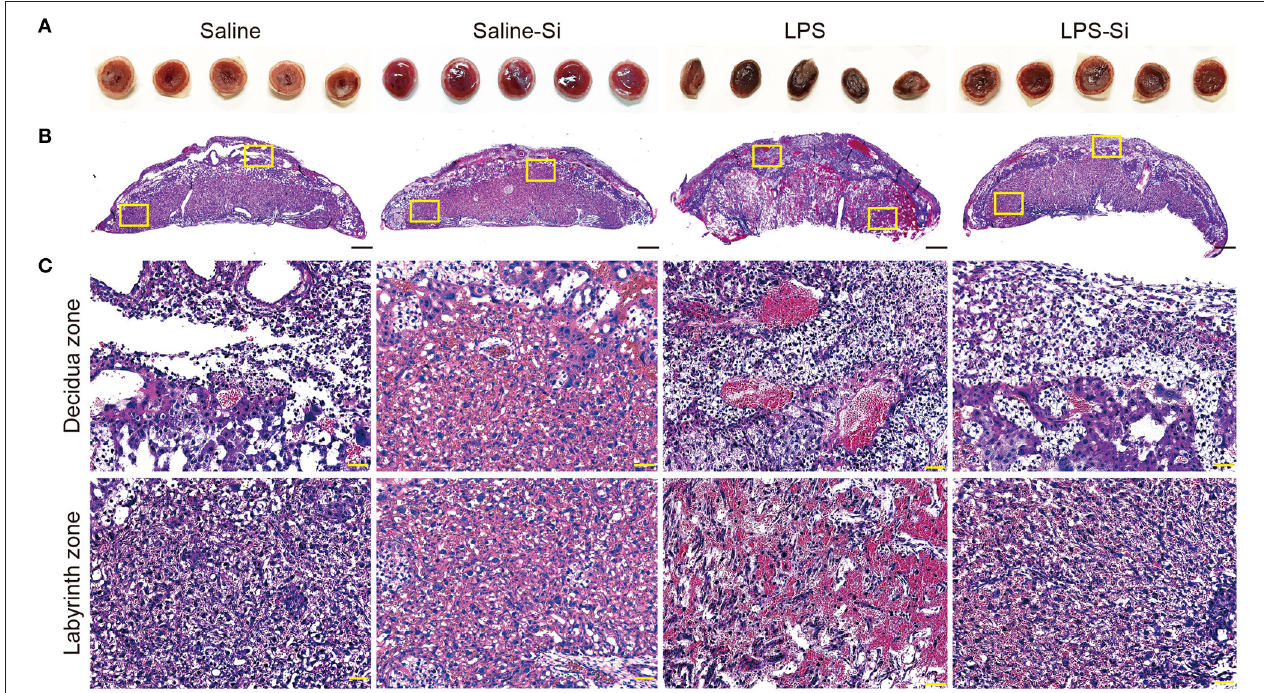
FIGURE 2 | Protective effects of the Si-based agent on the placenta. (A) Representative image showing the central region of mouse placenta at 4h after the second administration. The Si-based agent protected against placental atrophy. (B) Hematoxylin-eosin (HE) staining showing the mouse placental sections. (C) High-magnification images of mouse placental sections showing decidua and labyrinth zones highlighted in (B) . Neutrophil infiltration and vasodilation in the placenta were observed in LPS-treated mice, and placental damage due to inflammation was observed. Inflammation was attenuated by treatment with the Si-based agent. Scale bars: 500 µ m in (B) , 50 µ m in (C)